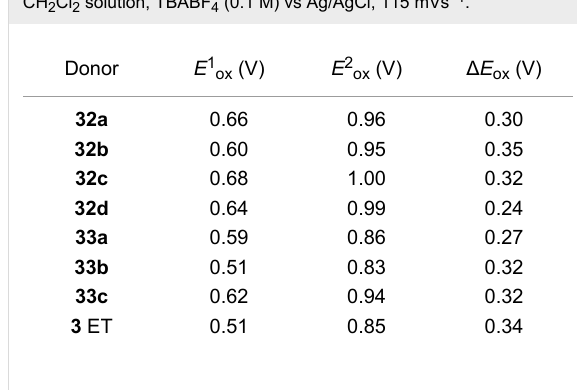
Table 2: Redox potential of 29 and ET 3 . in 1 mM MeCN solution, NaClO 4 (0.1 M) vs Ag/AgCl, 100 mVs − 1 .